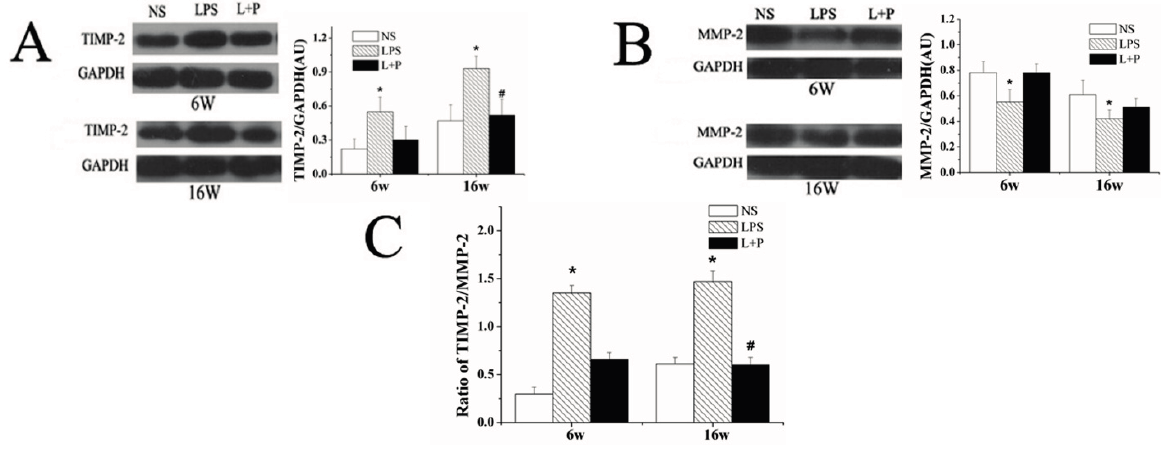
Figure 3. Effects of prenatal exposure to LPS or LPS + PDTC on the expression of TIMP-2 ( A ), MMP2 ( B ) and the TIMP-2/MMP2 ratio ( C ) in heart tissue from six- and 16-week-old rat offspring. The values are presented as the means ± SD. * p < 0.05 compared with the NS group; # p < 0.05 compared with the LPS